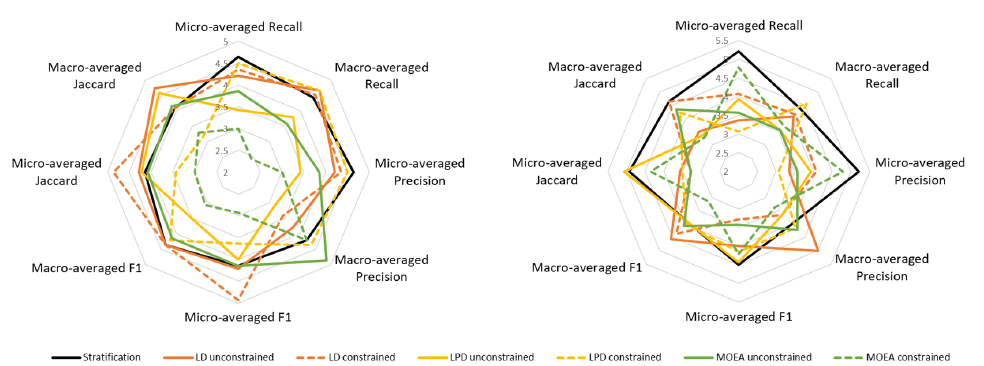
Figure 4. Average ranks of the different methods when classification is performed using Label Powerset. Left figure shows the ranks regarding classification metrics. Right figure shows the ranks regarding the variance over